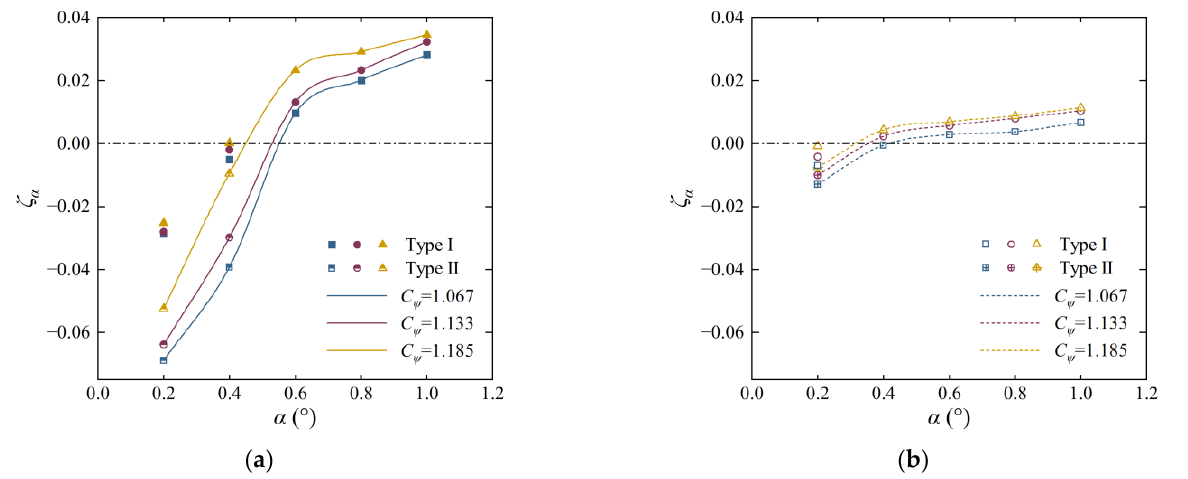
Figure 21. Damping ratios of GV torsional self-excited vibration: ( a ) GV-O ; ( b ) GV-M